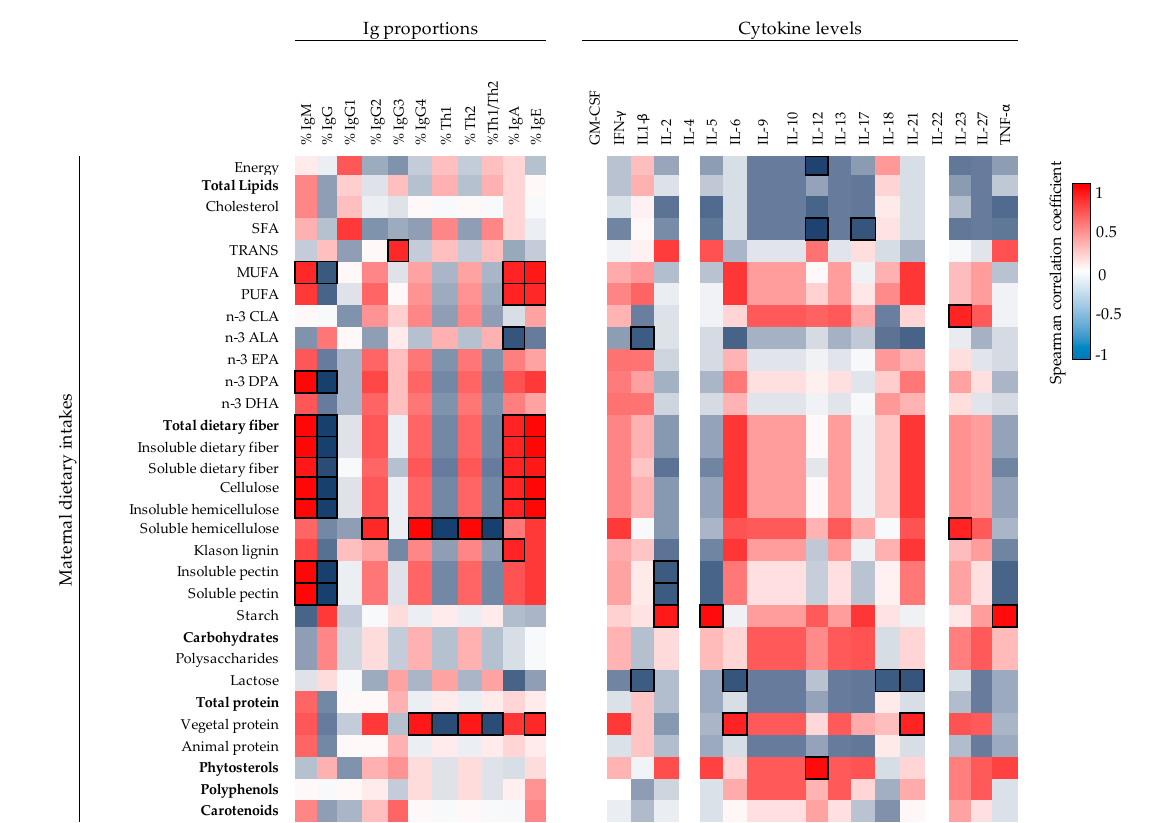
Figure 6. Correlations between Ig proportions, adipokine composition, and CK levels of UCP ( n = 6) with the maternal dietary intakes. The Spearman correlation coefficient is represented in the heat map following the color in the legend. Bold frames represent correlations with statistical significance ( p < 0.05). MP, maternal plasma; UCP, umbilical cord plasma; L/A ratio, Leptin/Adiponectin ratio. IgG1, IgG2, and IgG3 (Igs associated with Th1 response); IgG4 (Ig associated with Th2 response) [30,31].